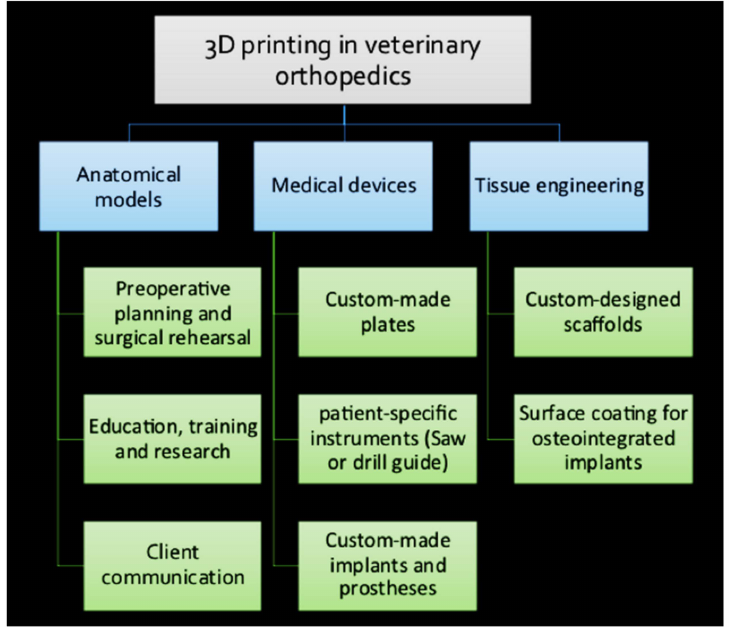
Figure 4. Summary of application of 3D printing in veterinary